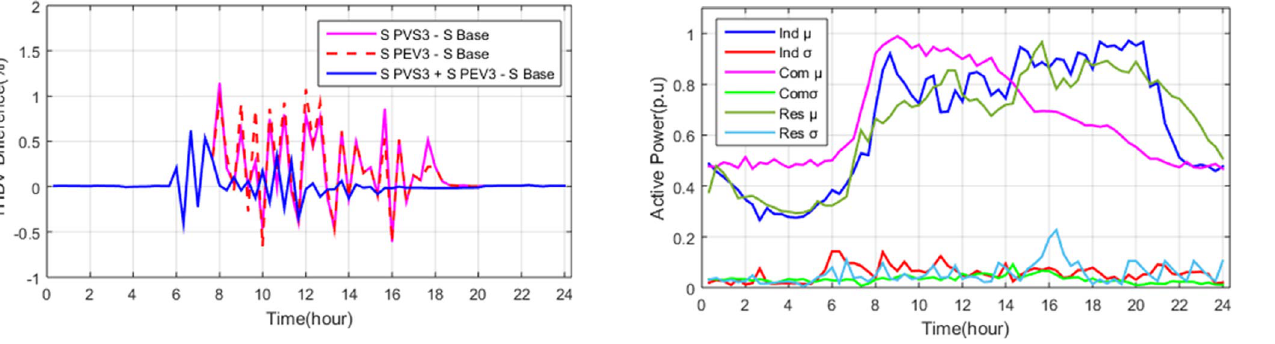
Figure 19. Analysis of statistical parameters of active energy pro fi les of lumped loads for